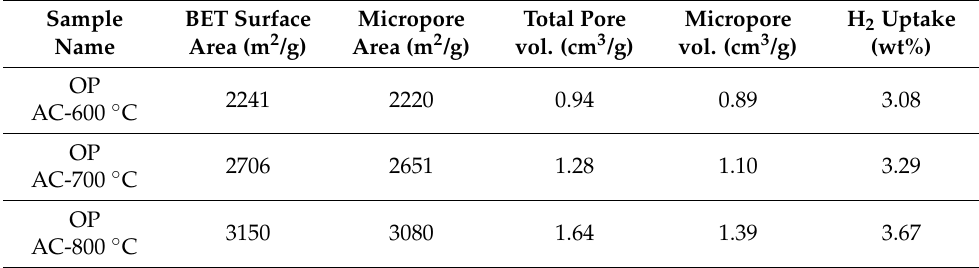
Table 1. Textural properties of the onion peel-derived activated carbons produced at 600, 700, and 800 °C. Adopted with permission from [23], ©2020 The Authors.